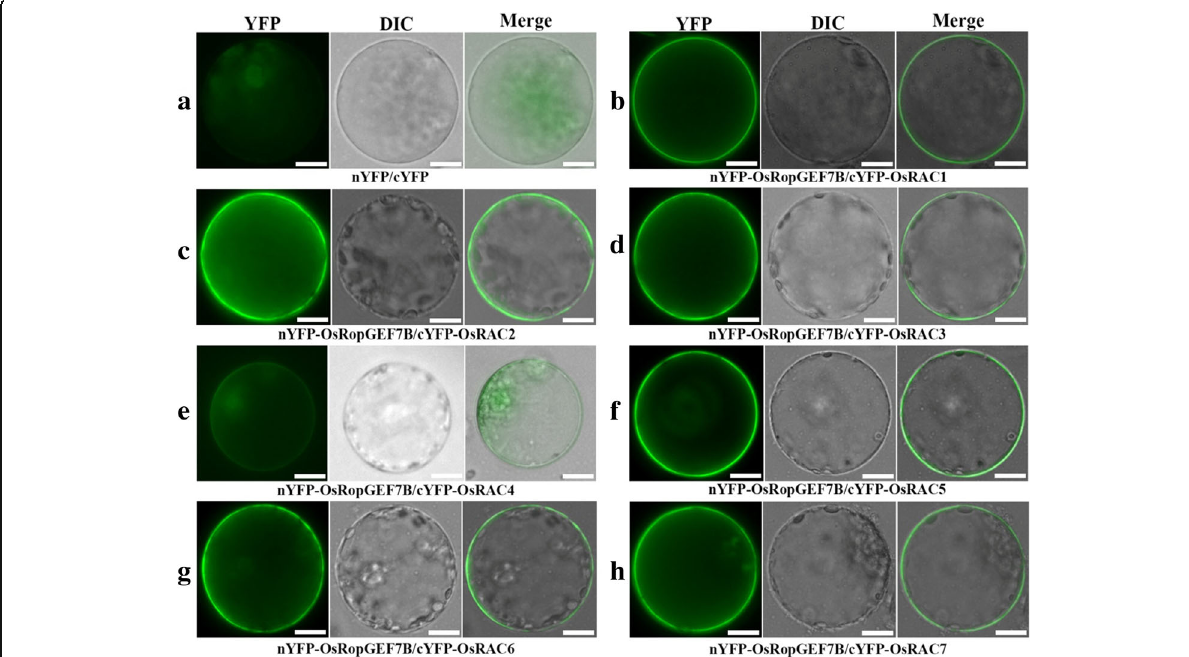
Fig. 6 OsRopGEF7B interacts with OsRACs in rice protoplasts. Rice protoplasts were co-transfected with ( a ) N-terminal YFP and C-terminal YFP , ( b ) nYFP-OsRopGEF7B and cYFP-OsRAC1 , ( c ) nYFP-OsRopGEF7B and cYFP-OsRAC2 , ( d ) nYFP-OsRopGEF7B and cYFP-OsRAC3 , ( e ) nYFP-OsRopGEF7B and cYFP-OsRAC4 , ( f ) nYFP-OsRopGEF7B and cYFP-OsRAC5 , ( g ) nYFP-OsRopGEF7B and cYFP-OsRAC6 , ( h ) nYFP-OsRopGEF7B and cYFP-OsRAC7 . Images were acquired under the YFP and differential interference contrast (DIC) channel, respectively, and then merged. Bars = 10 μ